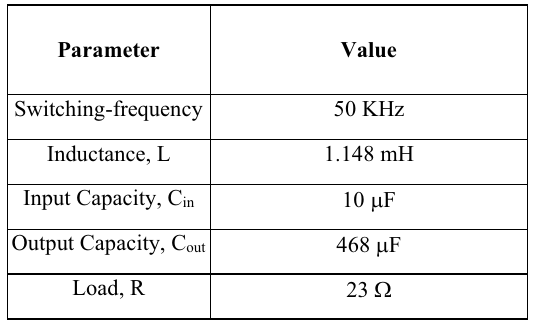
Table 1. Parameter of the boost DC-DC converter used